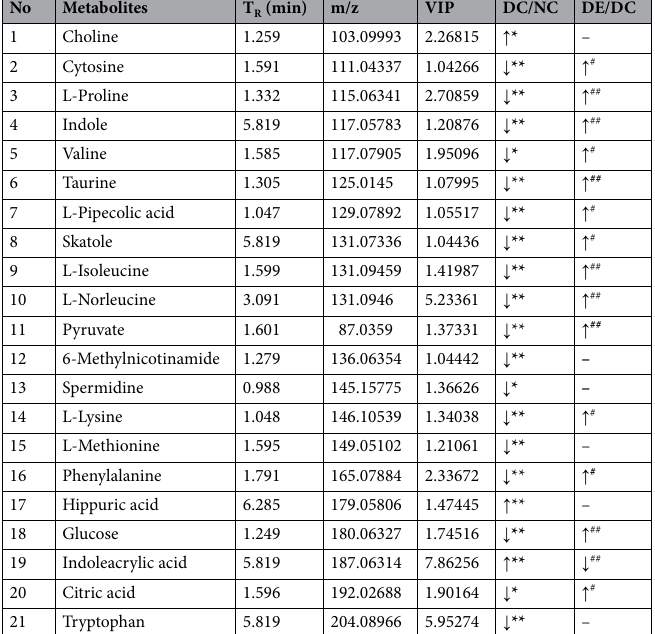
Table 1. Differential metabolites in the serum of CUMS rats with or without aerobic exercise. * p < 0.05, ** P < 0.01 versus NC; # p < 0.05, ## p < 0.01 versus DC; ↑ : Increase, ↓ :